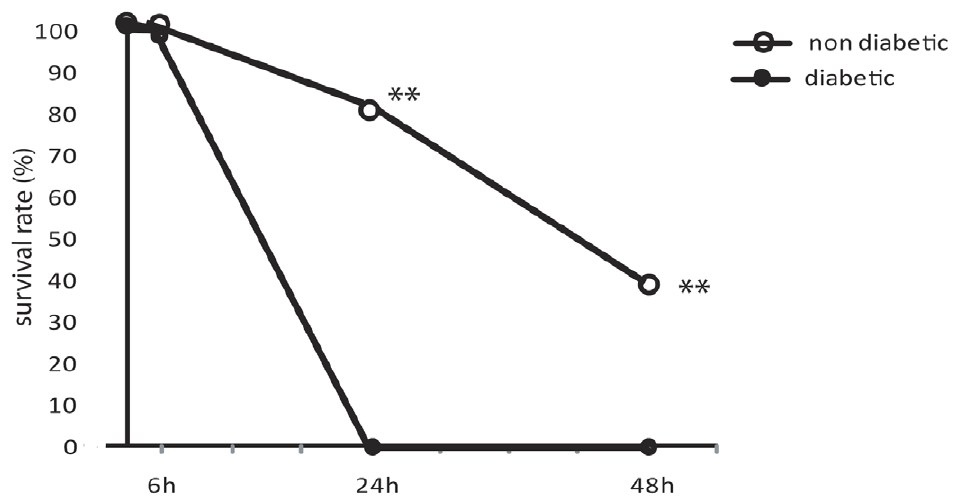
Figure 1. Survival rate. Percentage of diabetic and non-diabetic rats submitted to CLP-induced sepsis that died in a given time. Diabetes was induced by i.v. injection of alloxan (42 mg/kg/iv) in Wistar rats and 10 days later CLP was performed (12 punctures with a 20 G needle). n=5/group, repeated three times with identical results. Data are presented as mean 6 SEM. **P , 0.01 diabetic vs. non-diabetic.